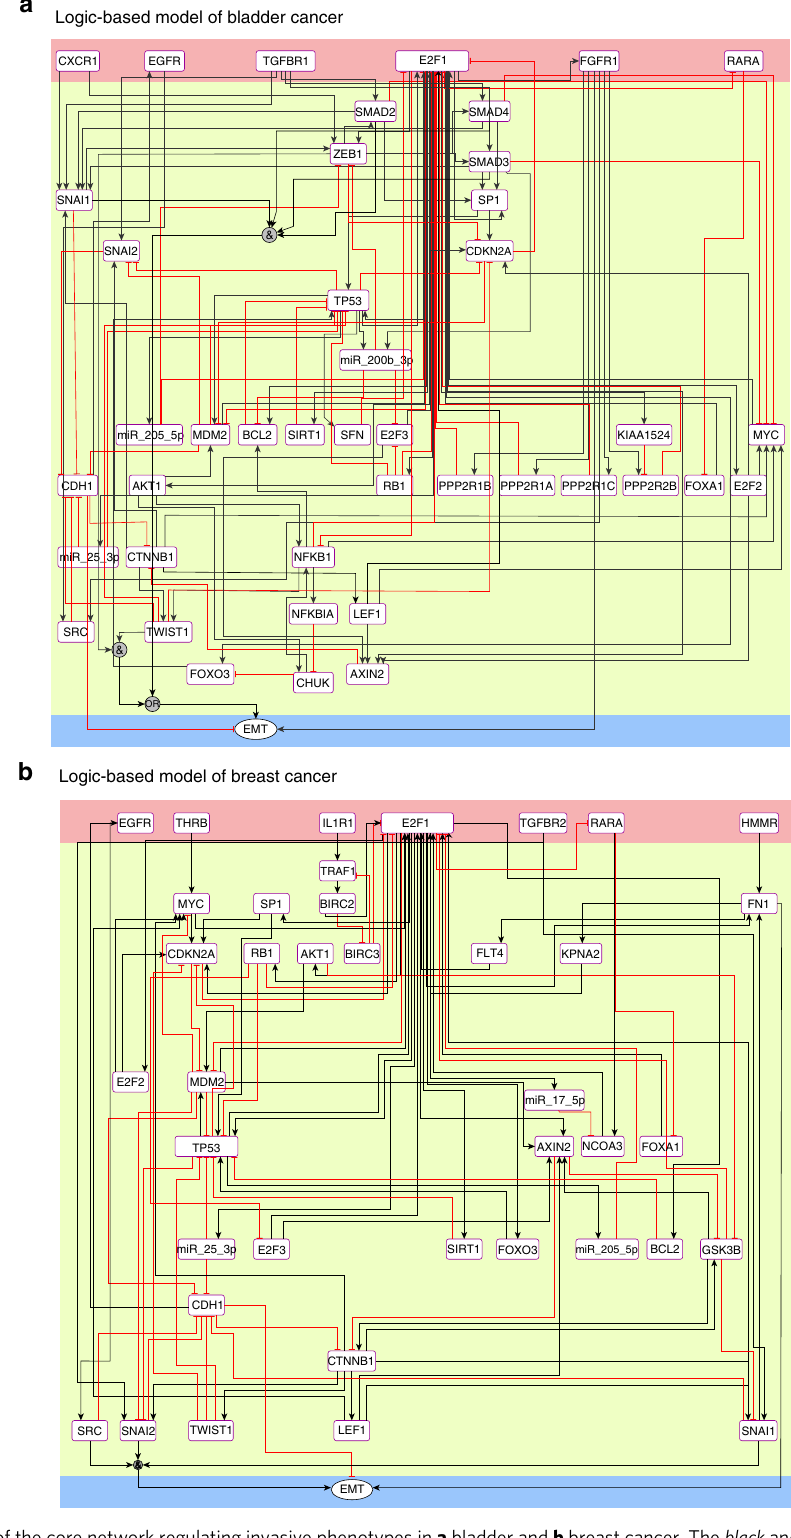
Fig. 4 Logic-based models of the core network regulating invasive phenotypes in a bladder and b breast cancer. The black and red lines represent the type of interactions (i.e., activation and inhibition) among the interacting components. The microRNAs, receptors, and proteins are represented by rectangular nodes , whereas the EMT phenotype is represented by an ellipse in the output layer. The model is divided into three layers, i.e., the input layer ( pink ), the regulatory layer ( yellow ), and the output layer ( blue